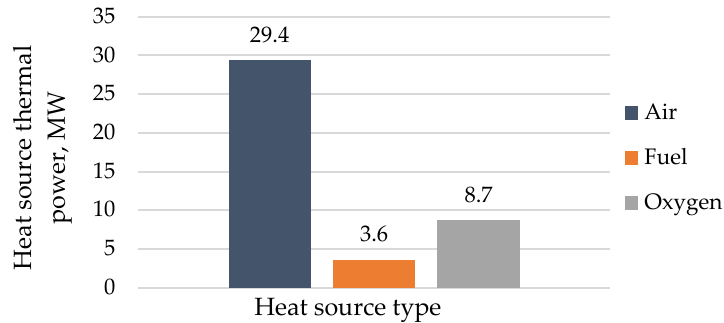
Figure 6. Thermal power of the low-heat sources.